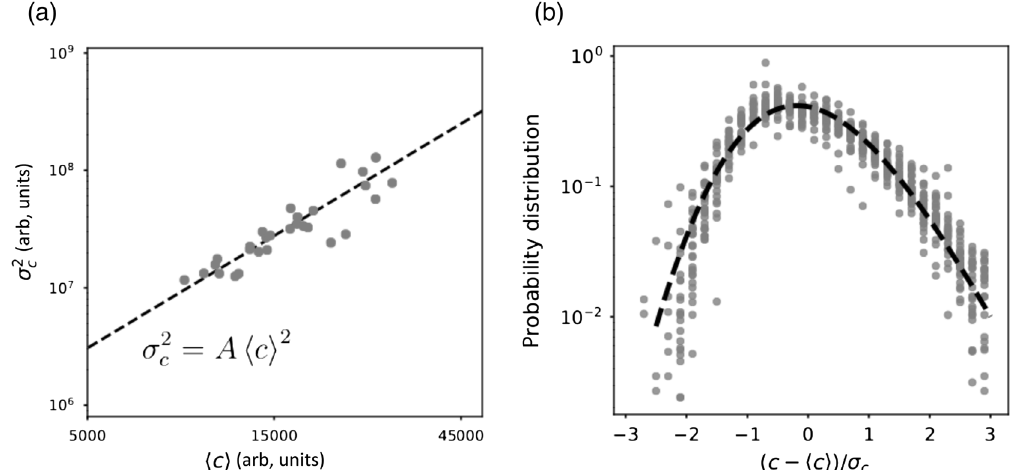
= h c i 2 . The value obtained in this set of data is c